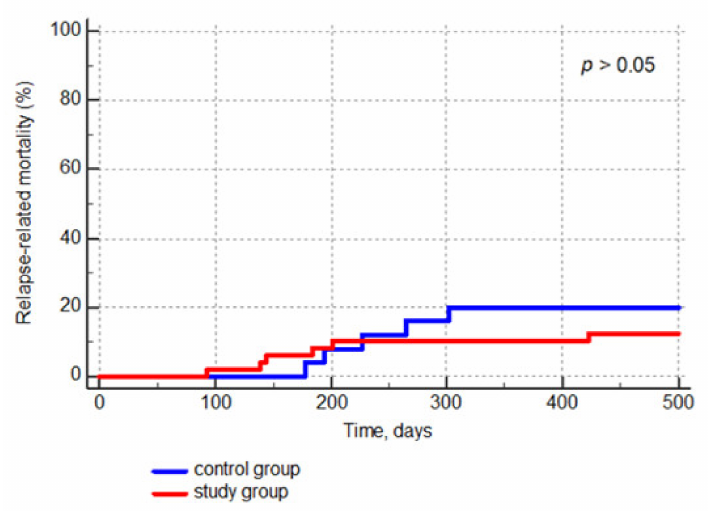
Figure 3. Comparison of the cumulative incidence curve for relapse-related mortality in the study group and the control